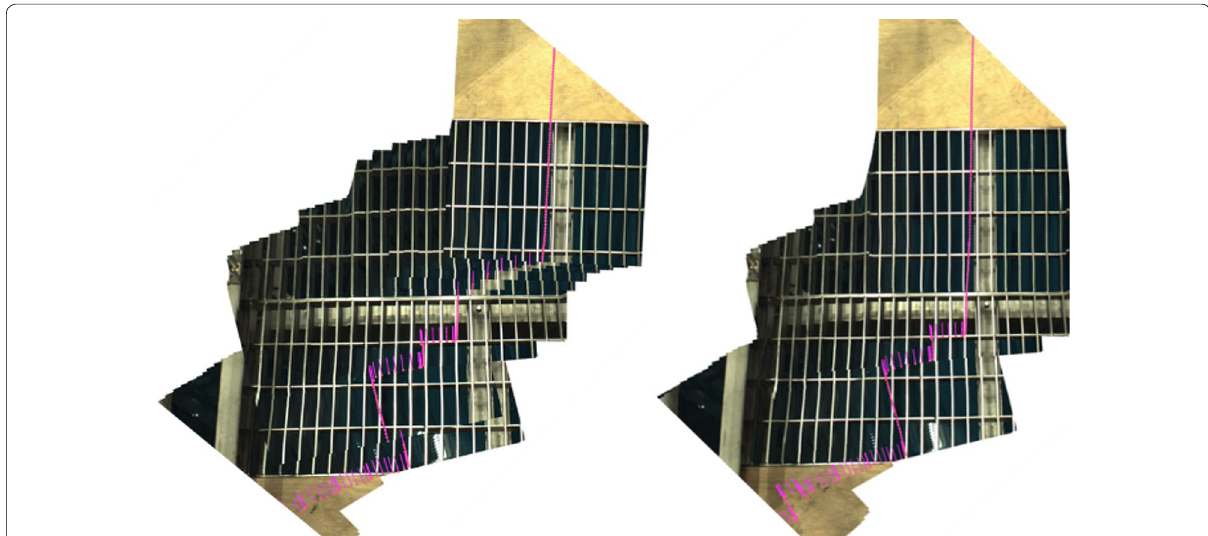
Fig. 8 Generated maps before (left) and after compensation (right)